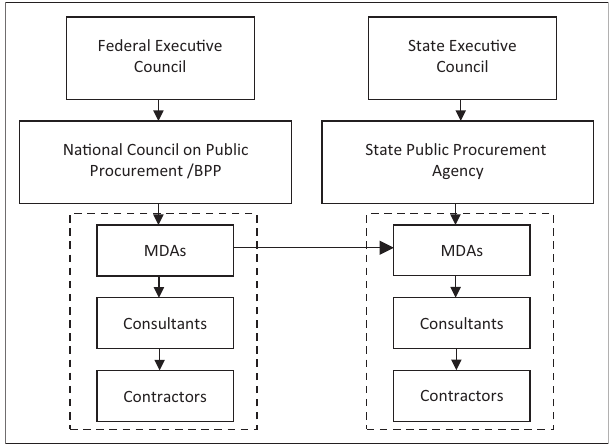
FIGURE 3: Nigerian public procurement